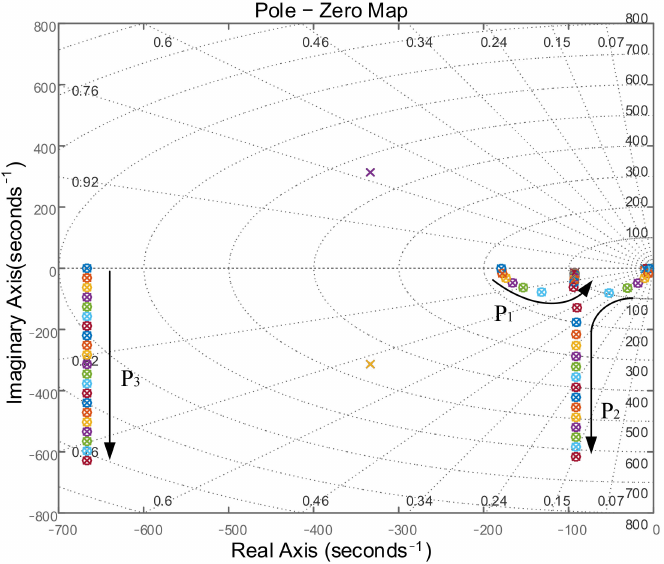
Figure 13. Zero-pole distribution of closed-loop transfer function for complex vector current control system.